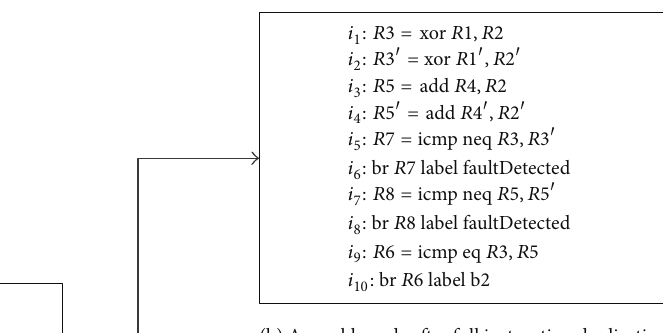
Figure 3. For consistency, we make use of the LLVM